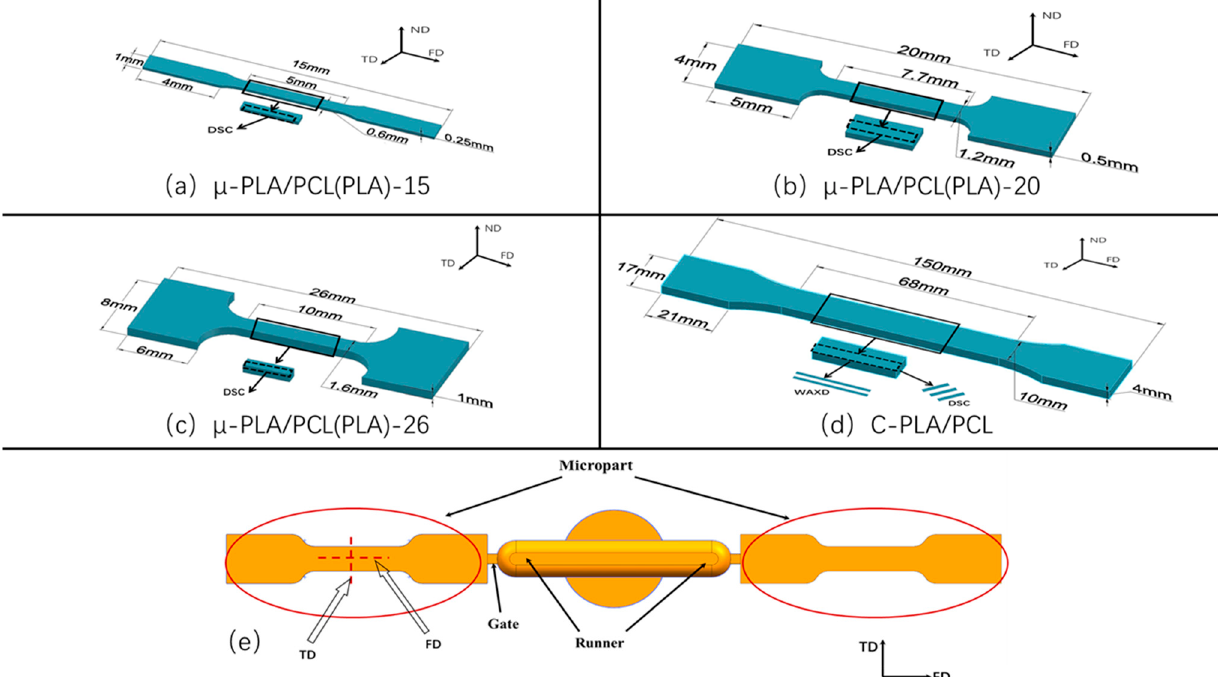
Figure 1. The dimension and shape of macropart and micropart with different cavity size: micropart 15 mm × 1 mm × 0.25 mm ( μ -PLA/PCL-15 or μ -PLA-15) ( a ), 20 mm × 4 mm × 0.5 mm ( μ -PLA/PCL-20 or μ -PLA-20) ( b ) and 26 mm × 8 mm × 1 mm ( μ -PLA/PCL-26 or μ -PLA-26) ( c ); macropart 150 mm × 17 mm × 4 mm (C-PLA/PCL) ( d ); the configuration of micropart cavity with different size in micro-mold tool ( e ). The whole micropart is used for WAXD analysis. FD: flow direction, TD: transverse direction, ND: normal direction.